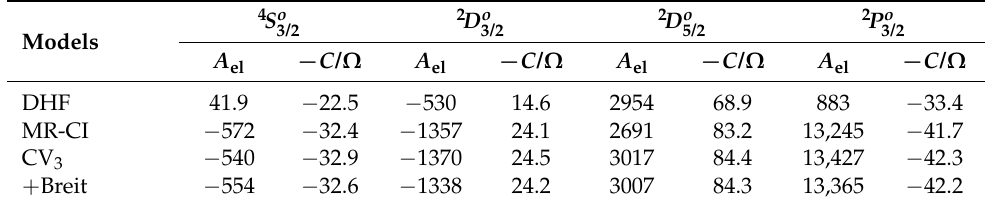
Table 1. Electronic factors of the magnetic dipole ( A el in MHz/ µ N ) and magnetic octupole ( − C / Ω in kHz/( µ N × b)) hyperfine interaction constants of states in the [Kr]4 d 10 4 f 14 5 s 2 5 p 6 5 d 10 6 s 2 6 p 3 ground configuration of